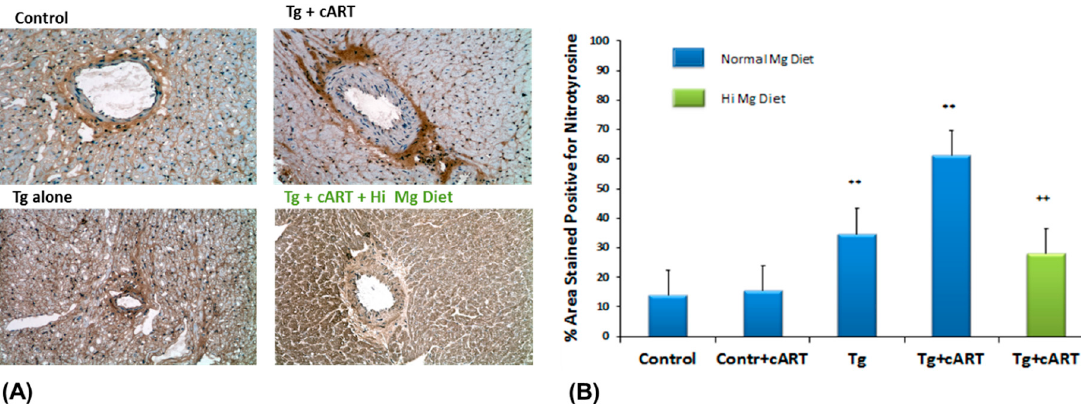
Figure 3. Representative micrographs for 3-nitrotyrosine formation in cardiac ventricular tissue of Ctl & HIV-1 Tg rats receiving cART with or without Mg-supplementation for 18 weeks ( A ); and % area stained positive for 3-nitrotyrosine ( B ). Values are means ± SE = 5 rats/group; ** p < 0.01 vs. Ctl, ++ p < 0.01 vs. Mg-normal Tg + cART.